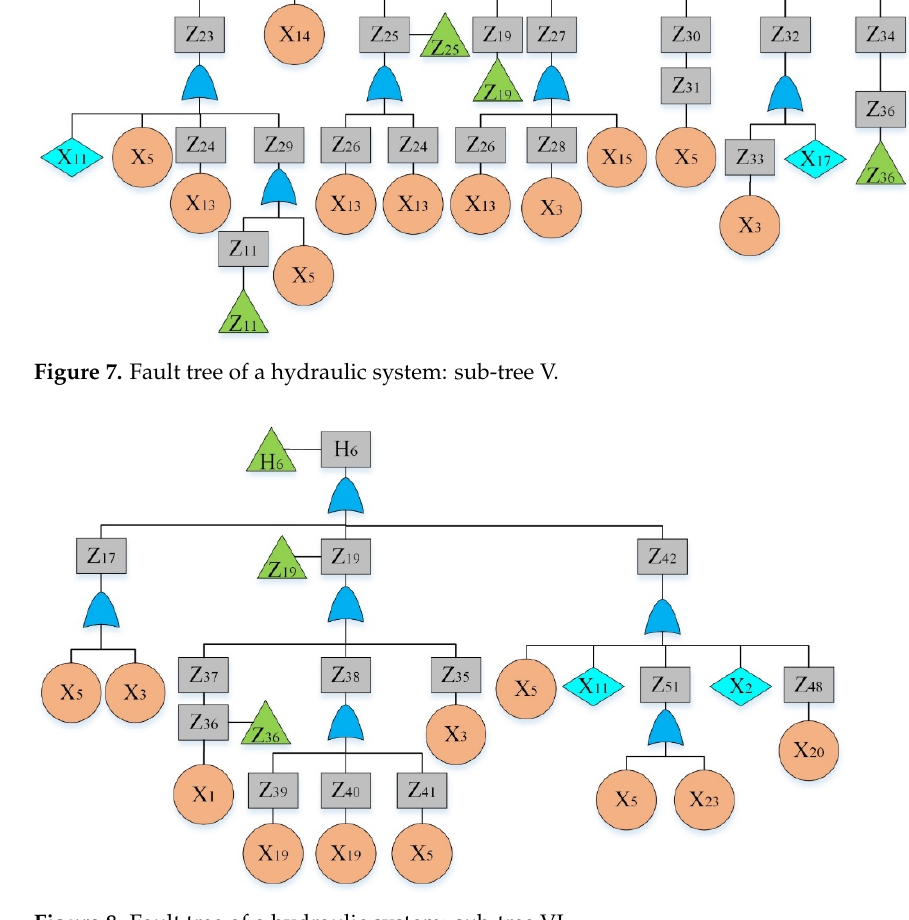
Figure 8. Fault tree of a hydraulic system: sub-tree VI.